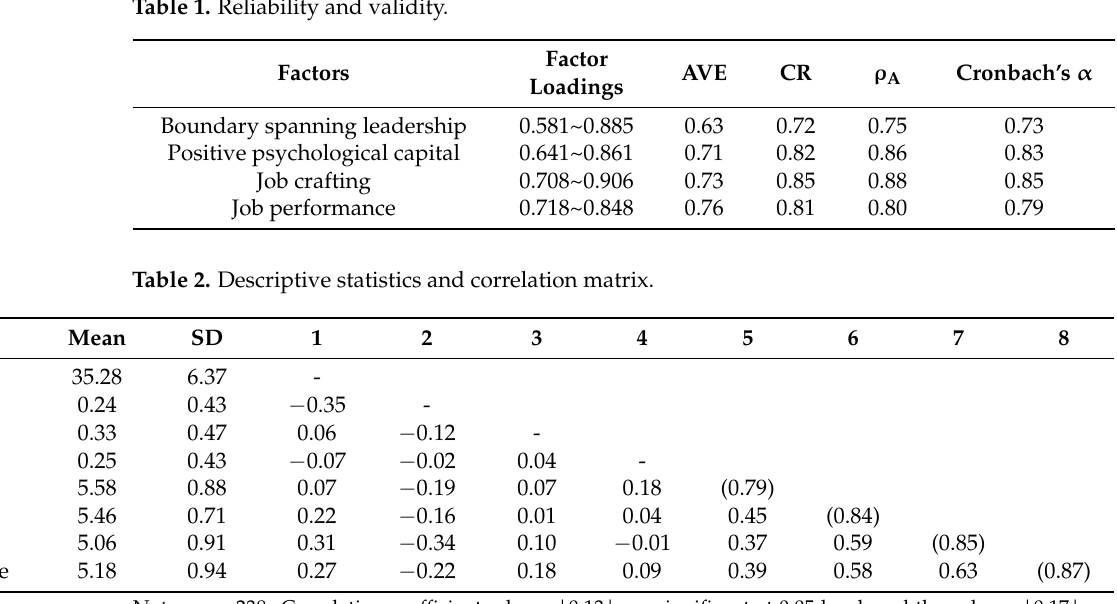
Table 1. Reliability and validity.